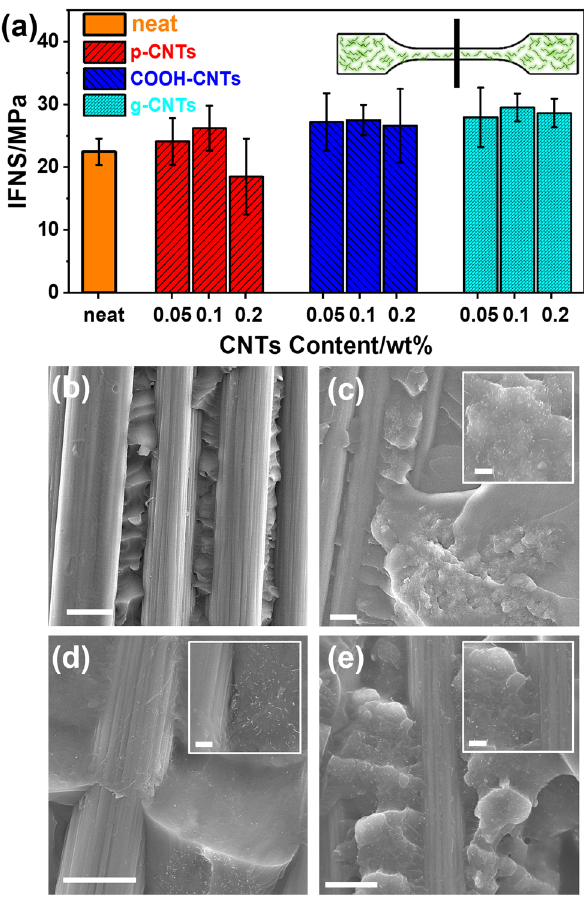
Figure 5: IFNS of matrix enhancement specimen with di ff erent nano fi ller loadings ( a ) and SEM images of neat ( b ) , p - CNTs ( c ) , C - CNTs ( d ) , and g - CNTs ( e ) treated TFBT sample with the loading of 0.1 wt%. The scale bars of main and insert images are 5 and 1 µm, respectively.